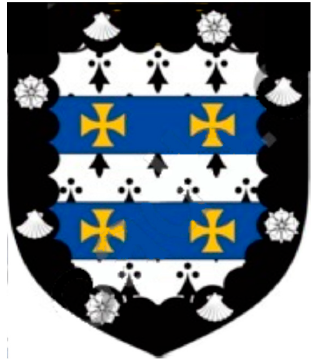
Figure 4. Arms of Rev. Dr. Samuel Parr.